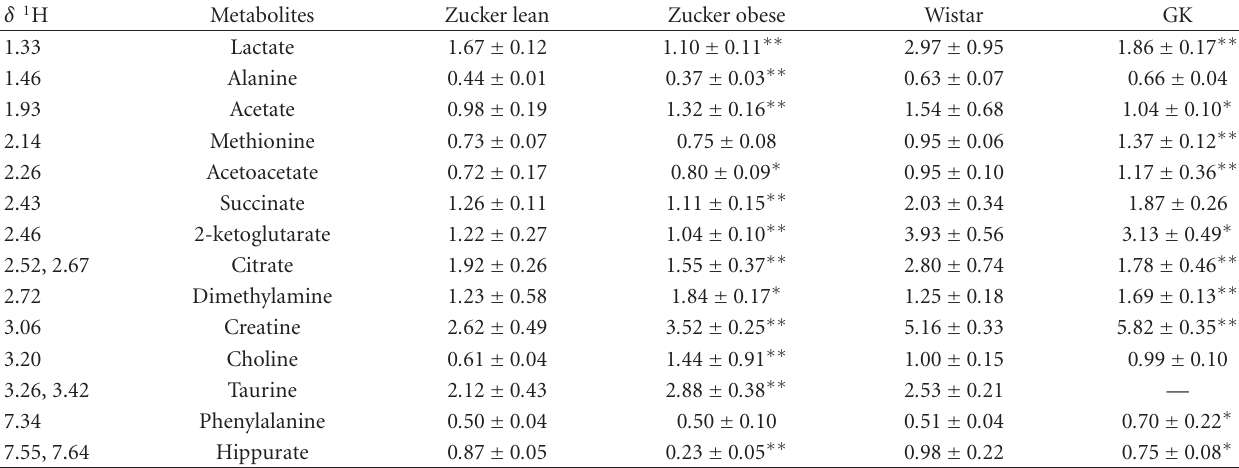
Table 1: Summary of the changes in relative amounts of urine metabolites of di ff erent group rats indicated by 1 H NMR spectra (mean ± SD).